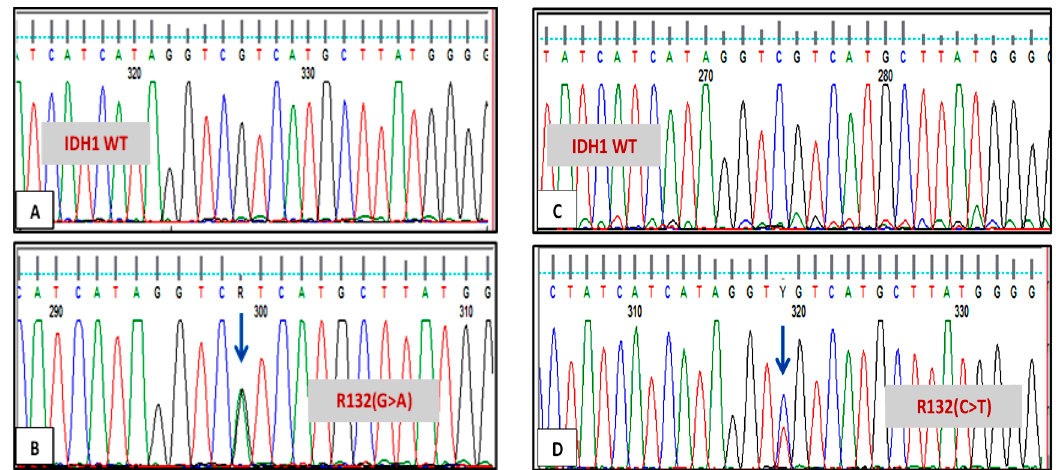
Figure 1. Sequencing result of IDH1 in two different patients. ( A , C ) Patient with normal IDH1 sequence at codon R132; ( B ) patient with IDH1 mutation at codon R132 (G>A); ( D ) patient with IDH1 mutation at codon R132 (C>T).